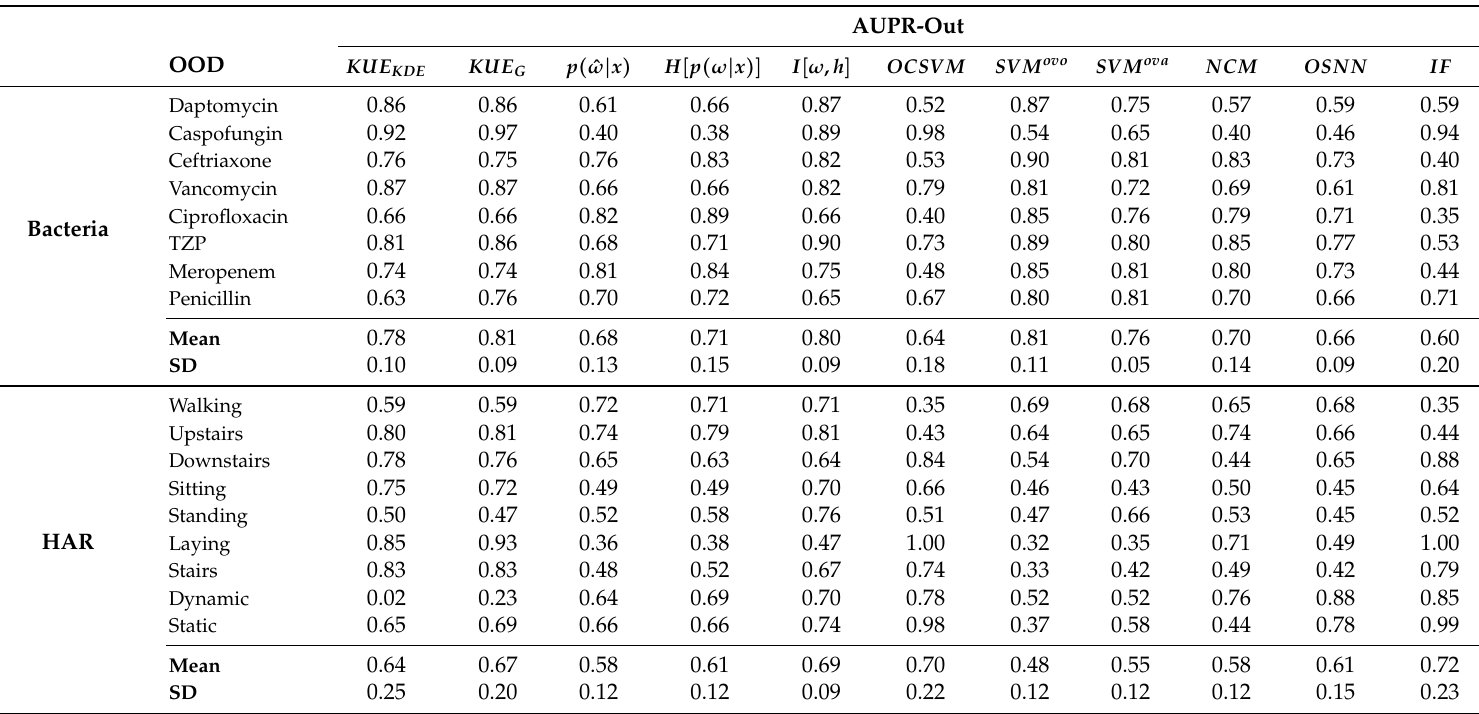
Table A3. AUPR-Out for detecting OOD test inputs using two variants of KUE (KDE and Gaussian) and other baseline methods on 4 datasets. The Mean and Standard Deviation (SD) over OOD combinations is presented after each dataset. All values are averages over 10 consecutive